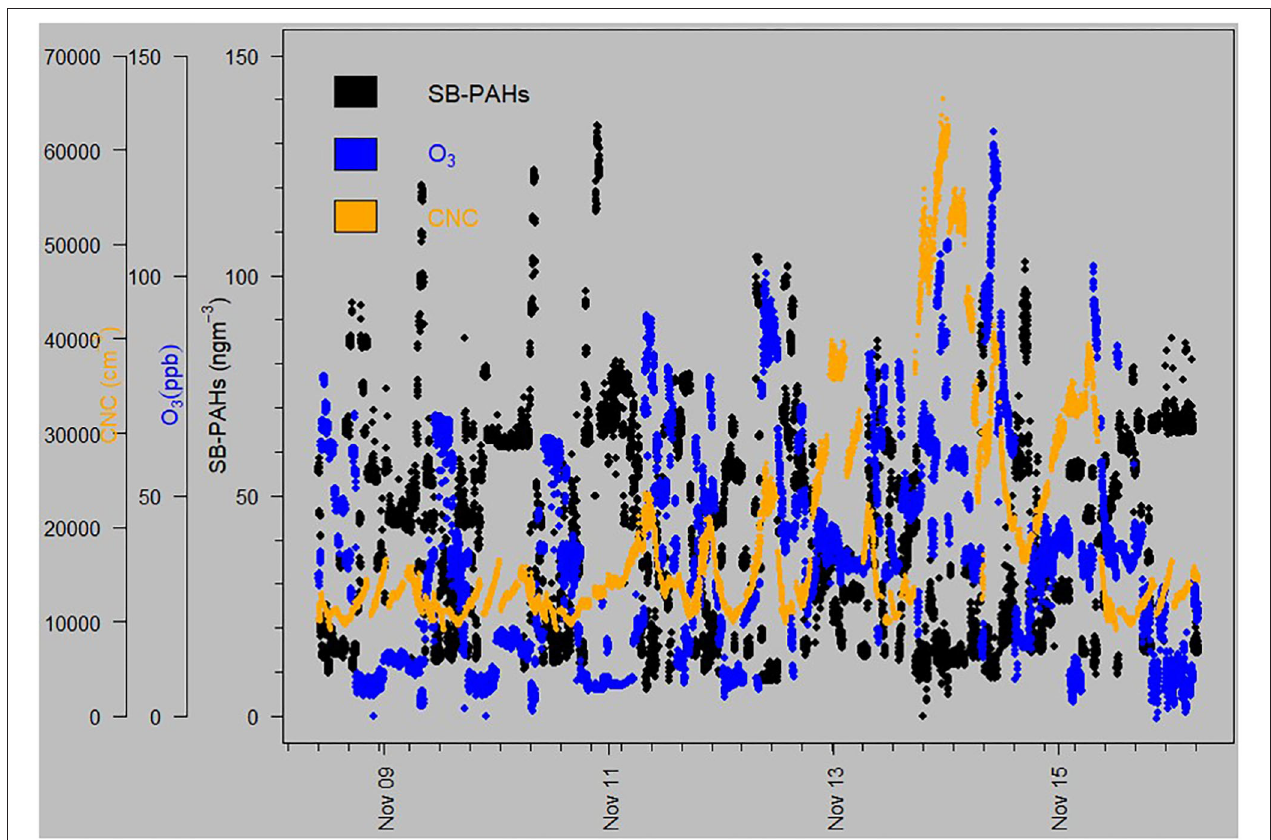
FIGURE 4 | Diurnal profile of simultaneously measured surface-bound PAHs, ozone, and CPC-based particle’s number concentration (CNC) during entire campaign.